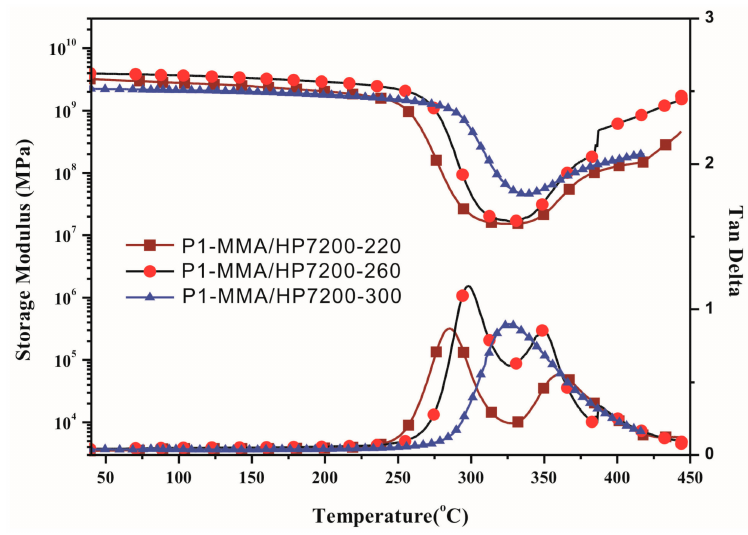
Figure 7. DMA thermogram of P1–MMA/HP7200 under three different curing temperature.